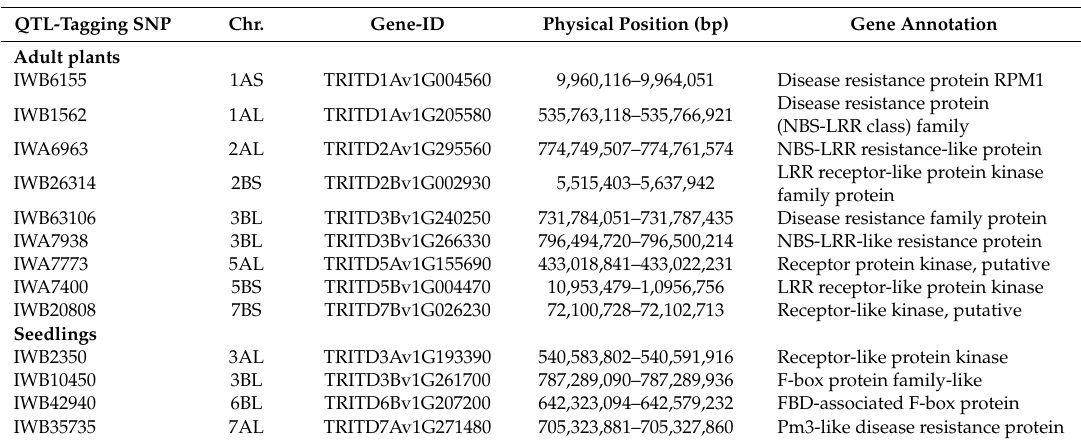
Table 3. Candidate genes for the quantitative trait loci (QTL) for seedlings and adult plants resistance to Blumeria graminis f. sp. tritici in a tetraplod wheat collection. Physical position to the genome assembly of Triticum turgidum ssp. durum cv. Svevo.v1